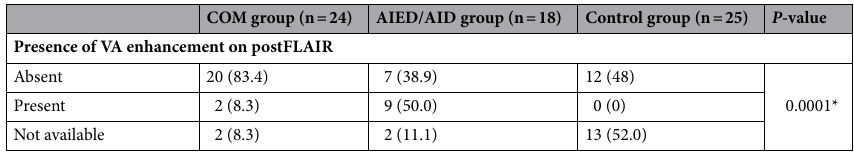
Table 1. MRI findings according to the clinical diagnosis. Data are presented as n (%). MRI magnetic resonance imaging, COM chronic otitis media, AIED/AID autoimmune/autoinflammatory inner ear disease, preFLAIR pre-contrast fluid-attenuated inversion recovery image, postFLAIR post-contrast fluid-attenuated inversion recovery image, postT1WI post-contrast T1-weighted image, RW sign round window sign, VA vestibular aqueduct. *Statistical significance was set at P < 0.05.